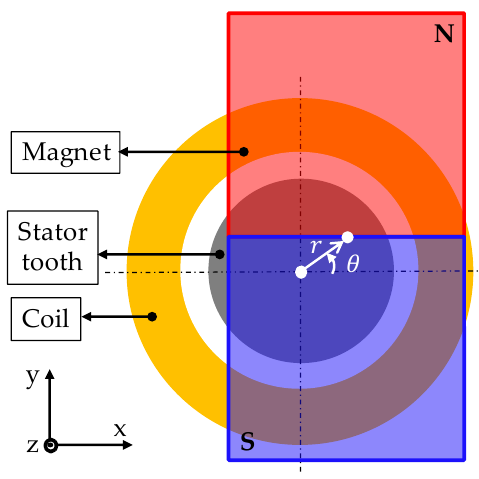
Figure 3. Translation of mover on U-phase.